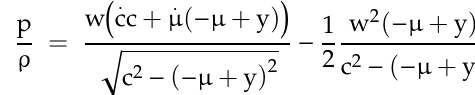
Figure 2. Impact with asymmetry entry.